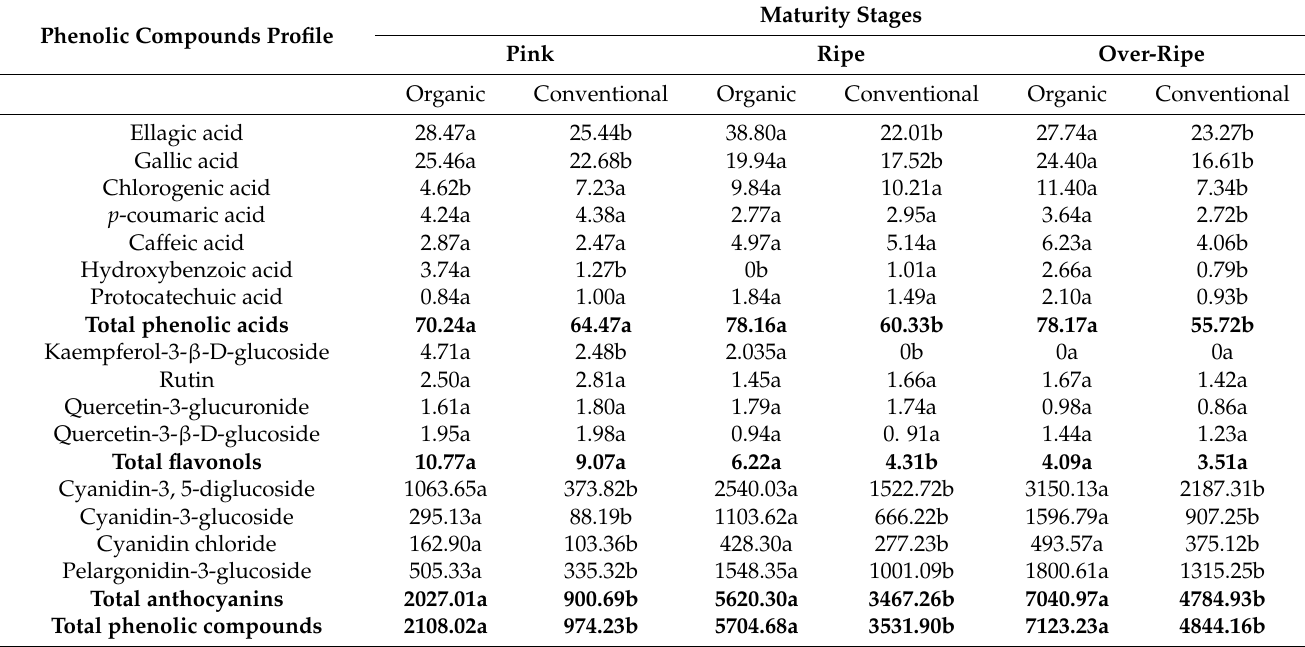
Table 5. Polyphenols profile (mg/100 g dry weight DW) in raspberry fruits at three maturity stages, pink, ripe, and overripe, grown under organic or conventional